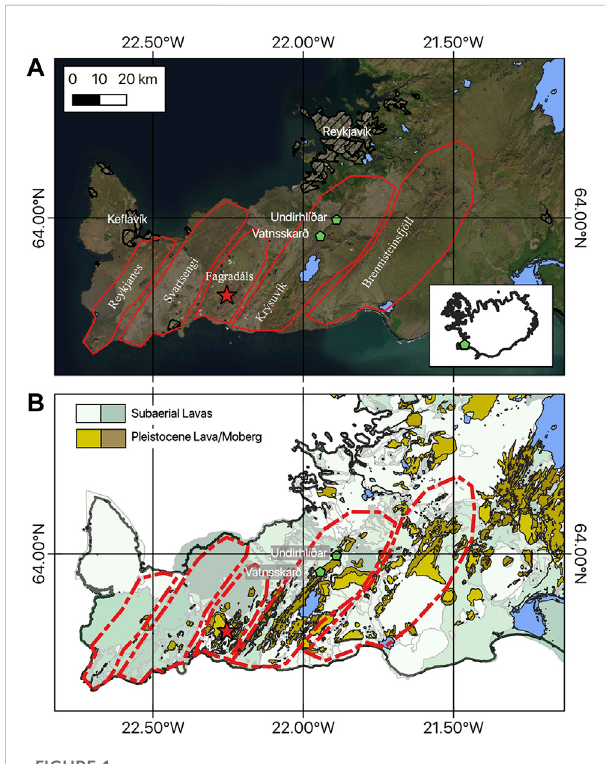
FIGURE 1 Location of fi eld area. (A) Satellite image (ESRI Satellite plugin for QGIS)showingrelevantpartsoftheReykjanesPeninsula,includingthe 5 main fi ssures zones (Sæmundsson et al., 2020), the Fagradals eruption site, and the two quarries that bound the fi eld area. (B) Samemapelementsas (A) butusinggeological mappingfromÍSORto highlight glaciovolcanic (brown shades) versus subaerial